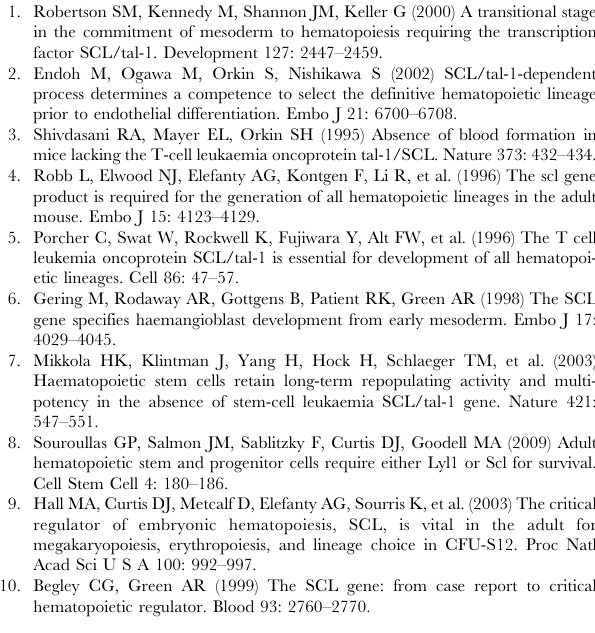
names which describe corresponding amplicons found in Table S2. Amplicon sizes and genomic sequence co-ordinates are taken from NCBI build 35. Table S7 Oligonucleotide primer pairs used to perform SyBr green quantitative real-time PCR for regions enriched for GATA1. Amplicon names in the first column are as described in Figure S2 (panel b) while the second column lists alternative names which describe corresponding amplicons found in Table S2. Amplicon sizes and genomic sequence co-ordinates are from NCBI build 35. Table S8 Oligonucleotide primer pairs used to perform SyBr green quantitative real-time PCR to detect reverse-transcribed cDNA for transcripts a, b and c of unknown function. Amplicon for transcripts a and b was from coding sequence shared by both transcripts - thus one amplicon represents both transcripts. The primer pairs for SCL and b -actin are also shown. Alternative names for the primer pairs are shown. Amplicon sizes and genomic sequence co-ordinates are taken from NCBI build 35. n.a. = not